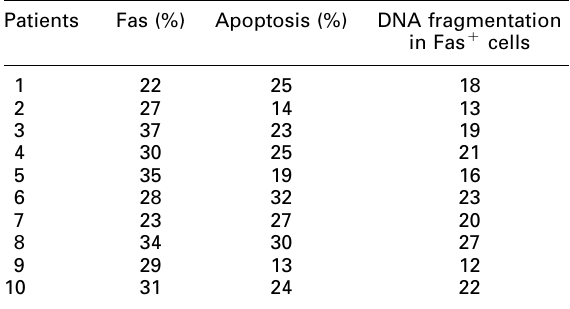
Table 2. The percentages of apoptosis in BAL mononuclear cells and Fas antigen expression Patients Fas (%) Apoptosis (%) DNA fragmentation